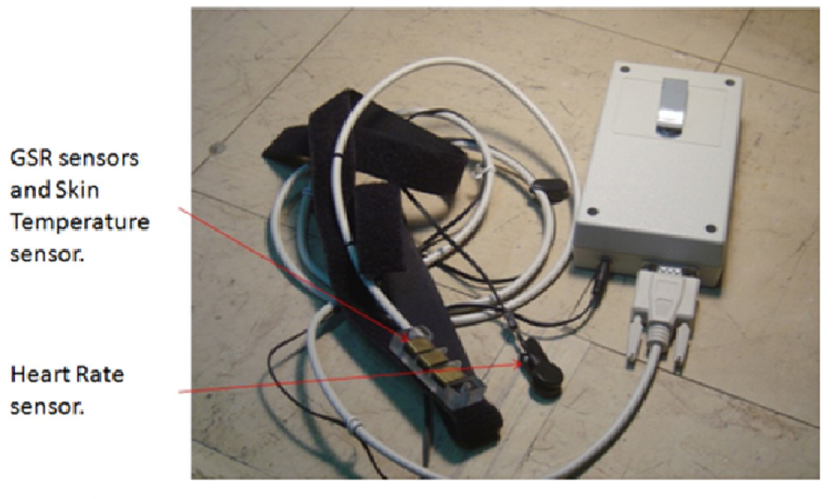
Fig 1. Biofeedback